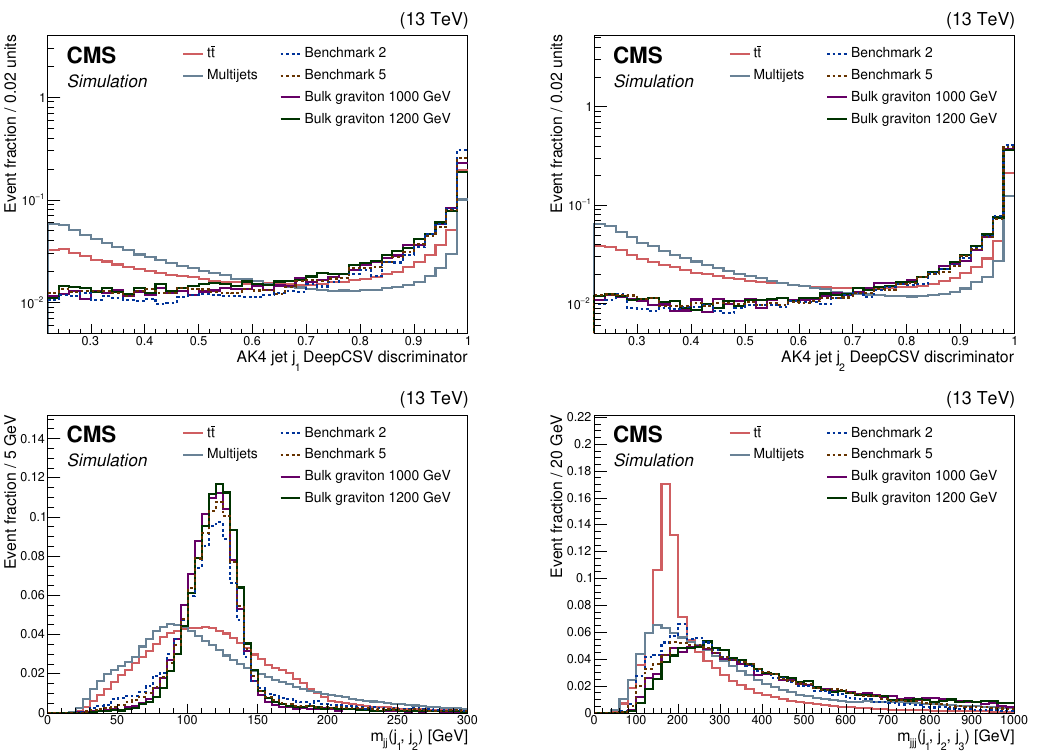
Figure 2 . Distributions for AK4 jets of the DeepCSV discriminators for the leading j and next leading j invariant mass of j events. The multijet and tt+jets background components are shown separately, along with the simulated signals for bulk gravitons of masses 1000 and 1200 GeV and the non-resonant benchmark models 2 and 5. The distributions are normalized to unity.